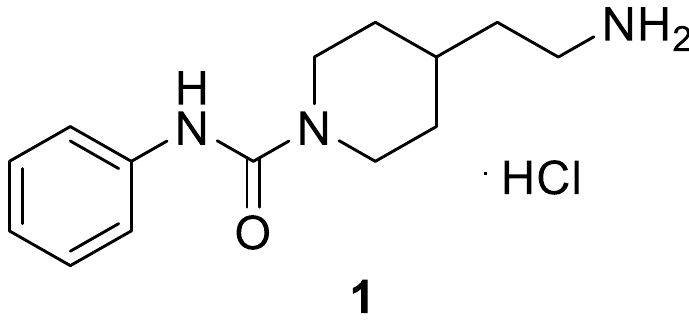
Figure 2. The structure of screening hit 1 selected as a starting point for the current program.